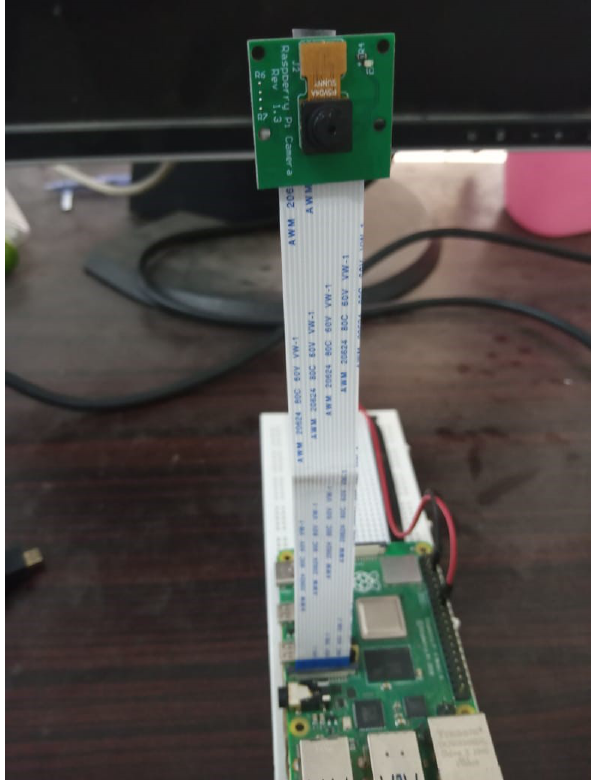
Figure 2. Pi-camera and associated